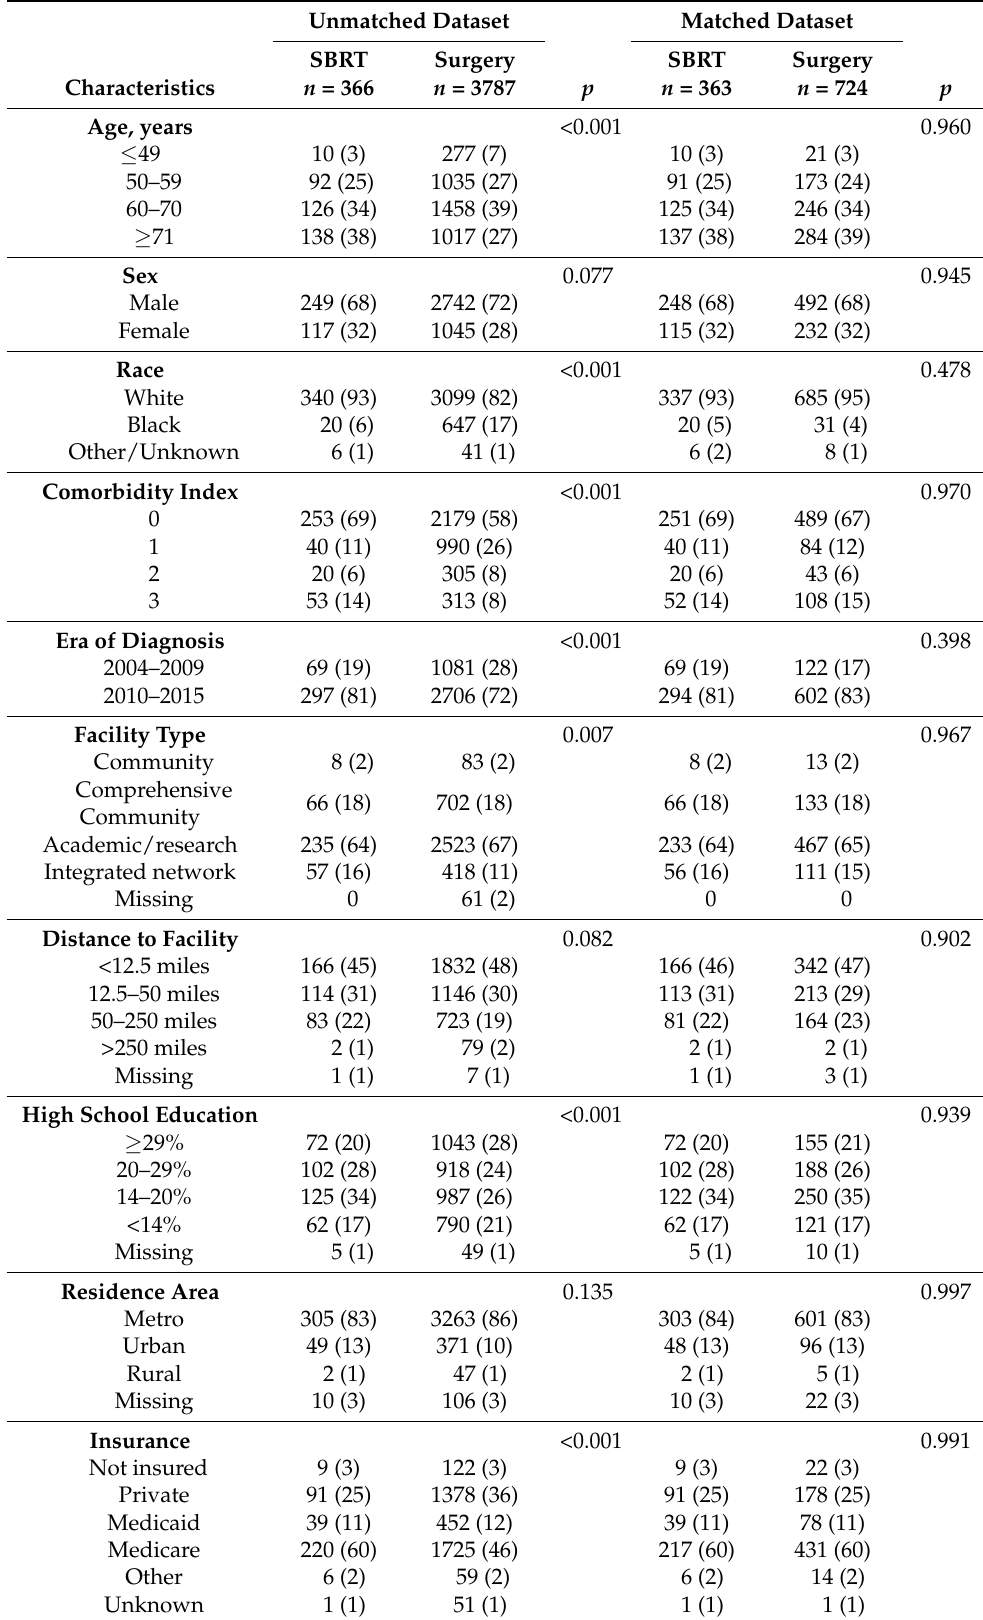
Table 1. Demographic and clinical characteristics of patients with hepatocellular carcinoma. Unmatched